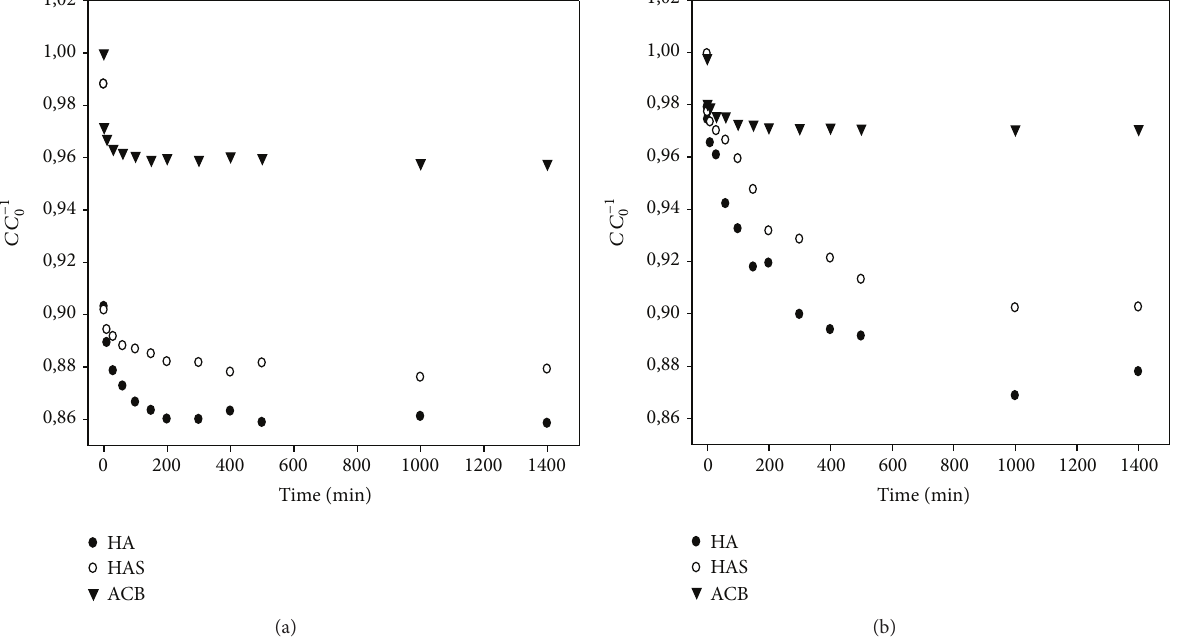
Figure 1: Kinetics of BSA adsorption on the surface of hydroxyapatite (HA), synthetic hydroxyapatite (HAS), and active babassu coal (ACB) at pH 4.0 (a) and pH 7.0 (b) at 25 ∘ C/24h, with final concentration ( 𝐶 ) and initial concentration ( 𝐶 0